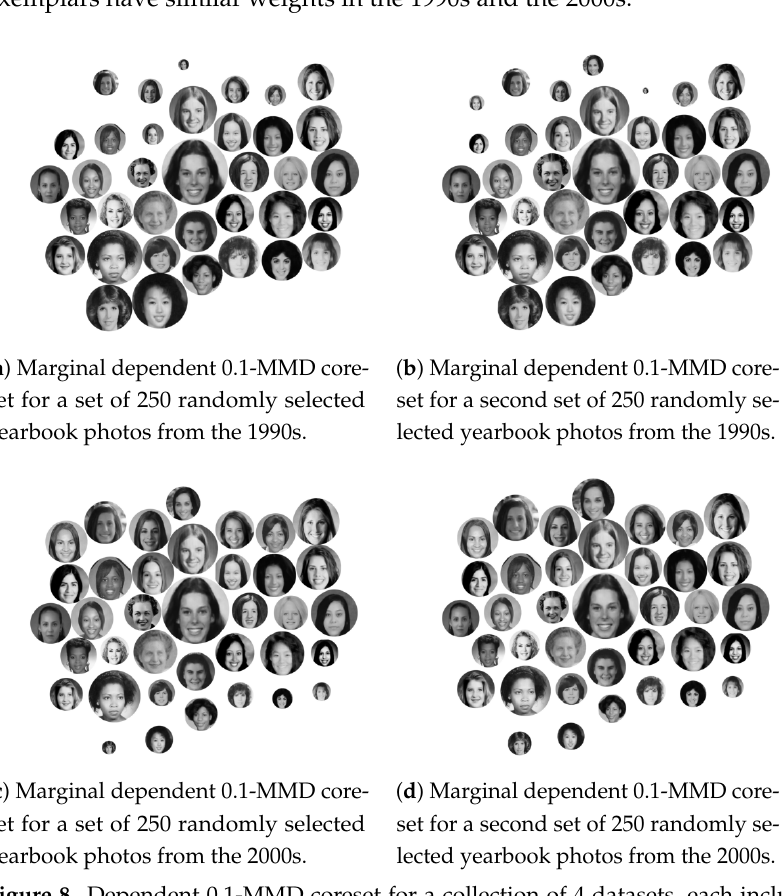
Figure 8. Dependent 0.1-MMD coreset for a collection of 4 datasets, each including 250 random samples from a given decade. Area of each bubble is proportional to the weight of the corresponding exemplar in the marginal coreset. Positioning is constant across all four